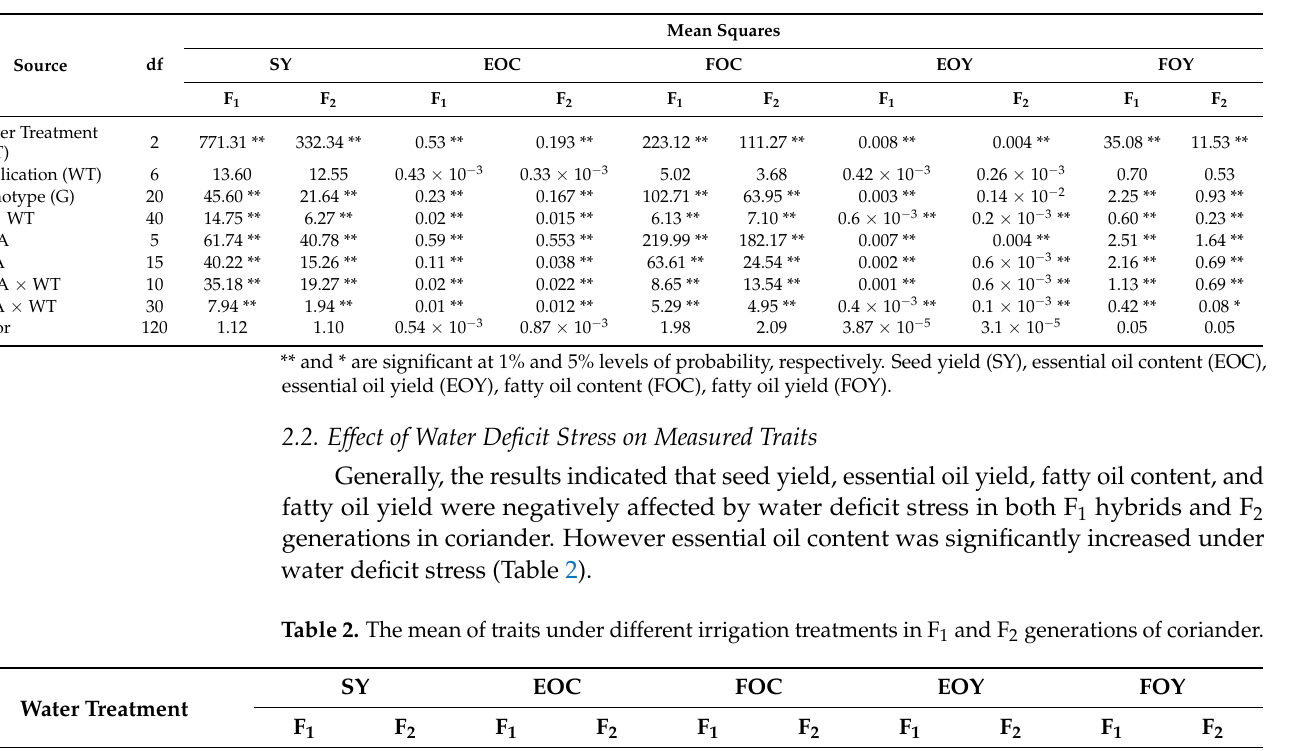
Table 1. Combined analysis of variance for phytochemical traits in the F 1 and F 2 generations under water treatments.